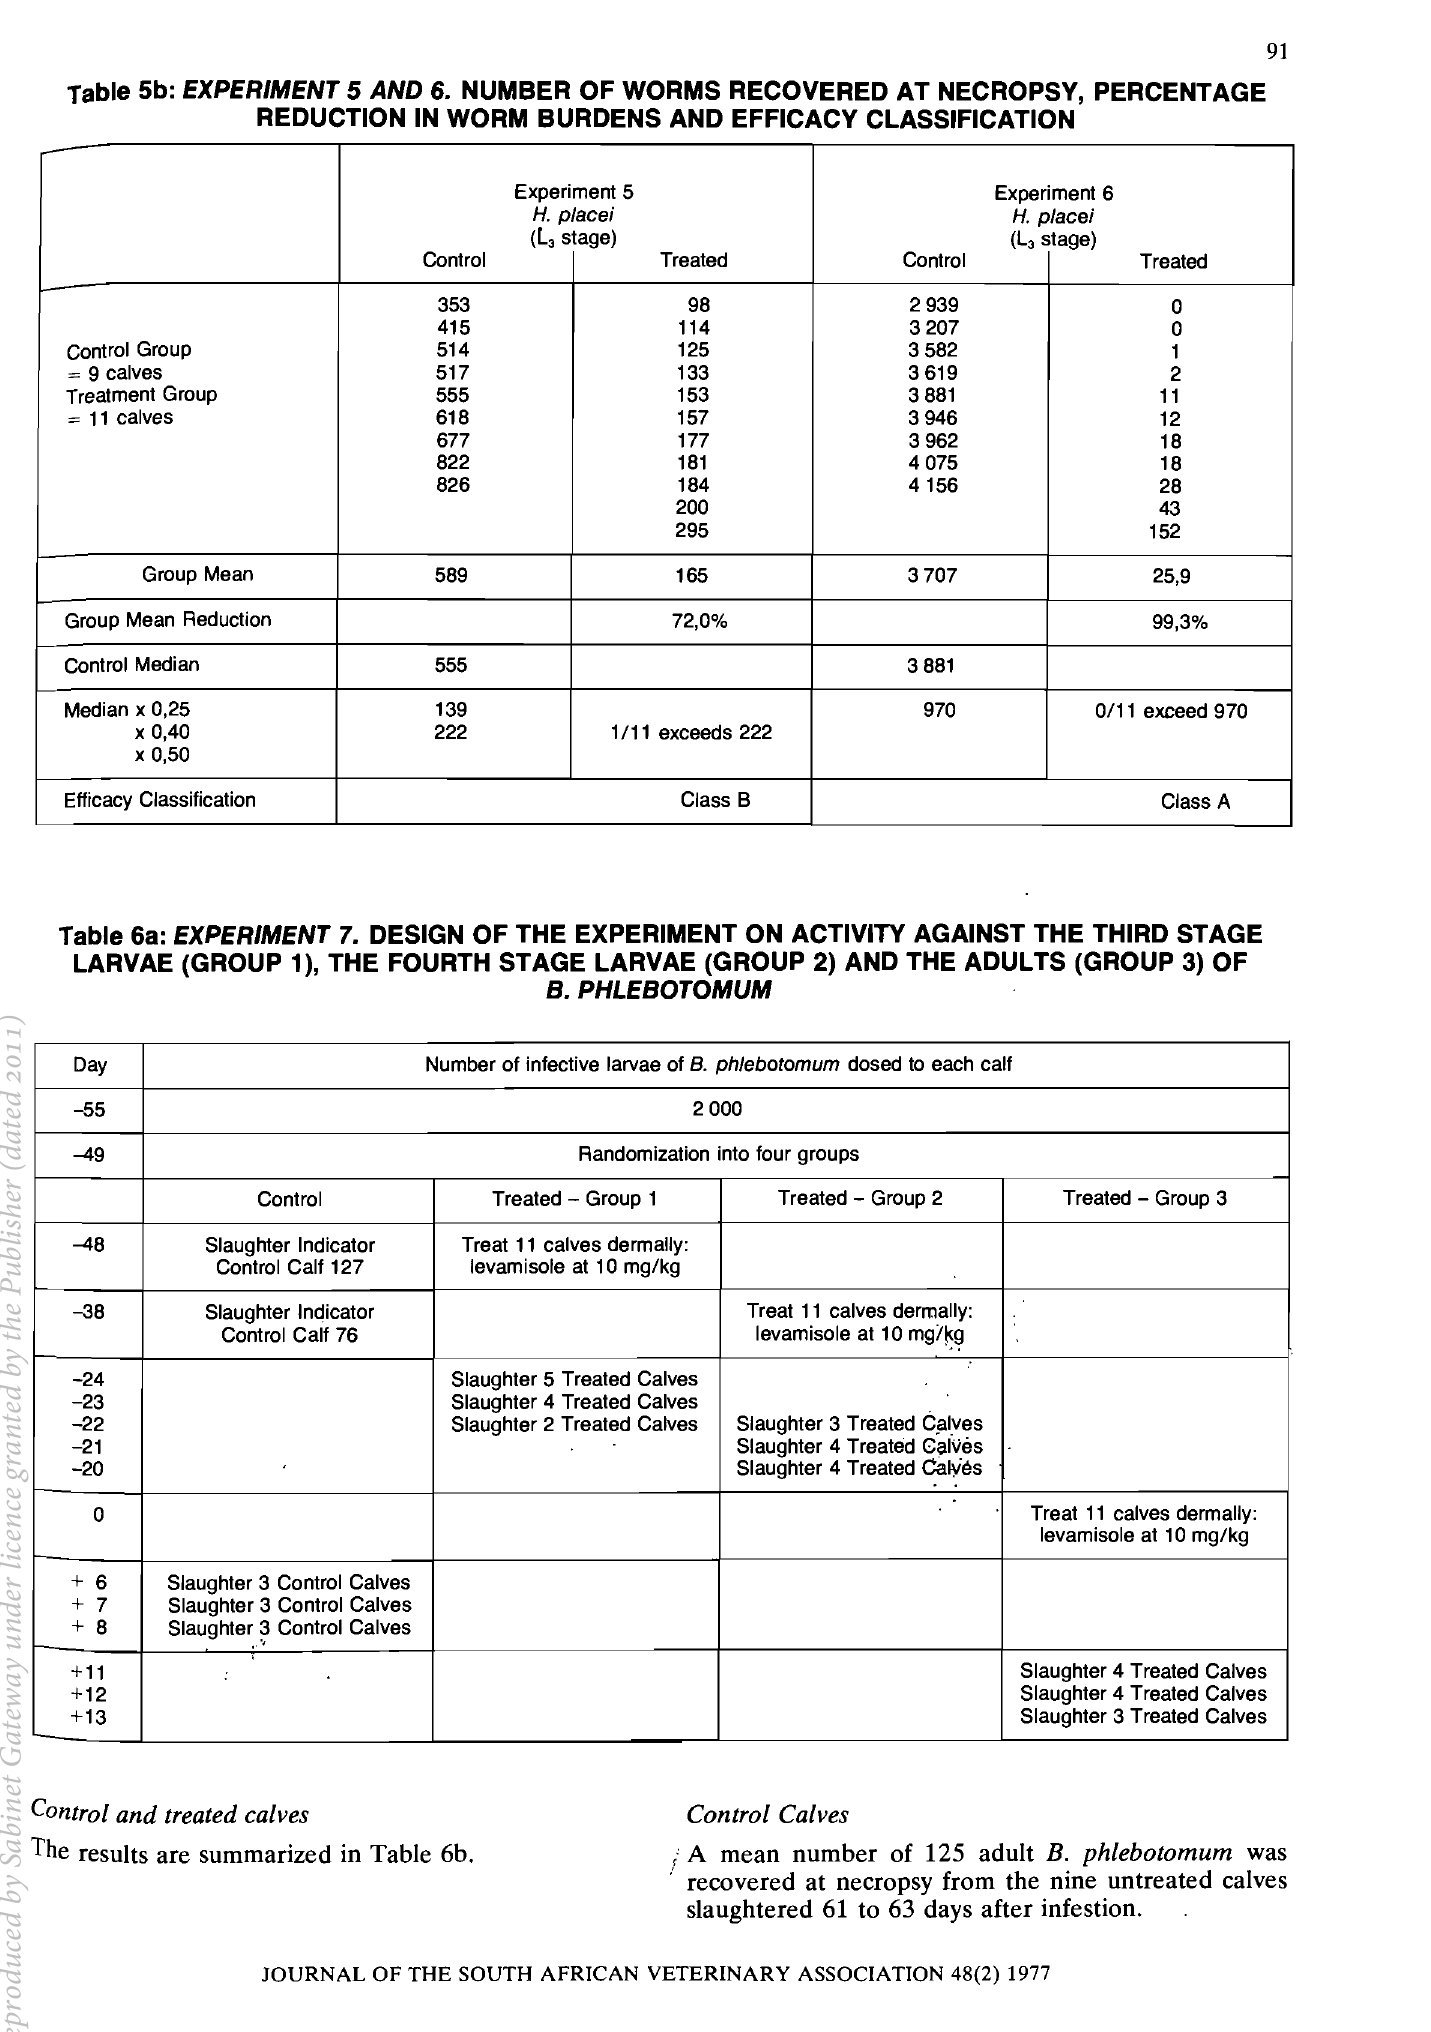
Table 6a: EXPERIMENT 7. DESIGN OF THE EXPERIMENT ON ACTIVITY AGAINST THE THIRD STAGE LARVAE (GROUP 1), THE FOURTH STAGE LARVAE (GROUP 2) AND THE ADULTS (GROUP 3)